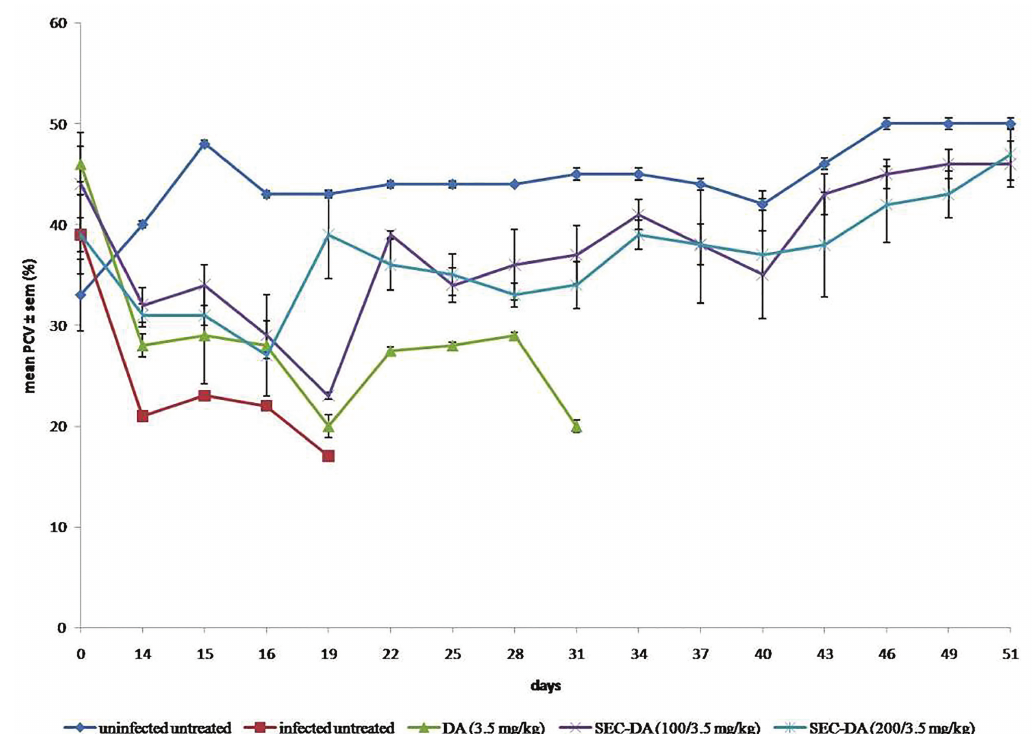
FIGURE 3 - Mean PCV in dogs infected with T. b. brucei and treated with combinations of SEC-DA and DA monotherapy. Dogs were infected on day 0 and treatment started 14 d.p.i. All infected untreated dogs died before 22 d.p.i. Data collection on PCV was terminated for a group as soon as relapse was recorded for that